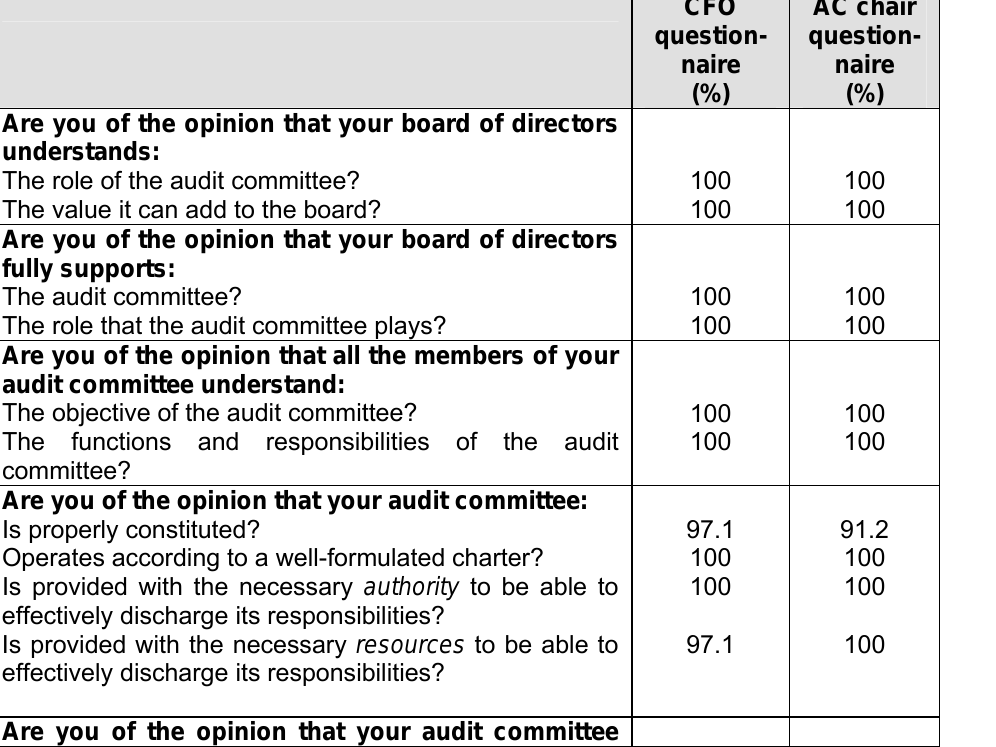
Table 2: Comparison of the views of the CFOs and audit committee chairs on the effectiveness